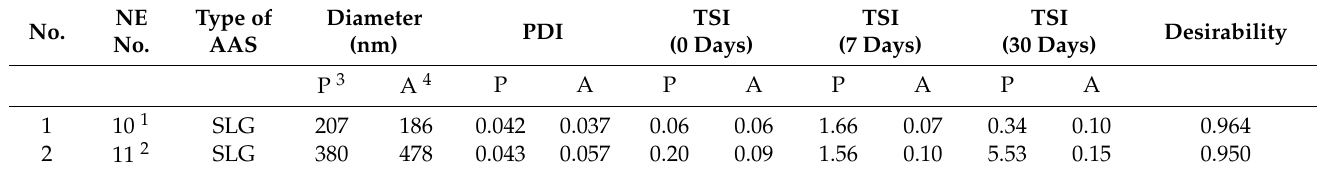
Table 3. Candidates proposed by the D-optimal model optimization for the best AAS-based w/o nanoemulsion graffiti eco-remover based on the desirability function and the correlation of the observed and predicted values.